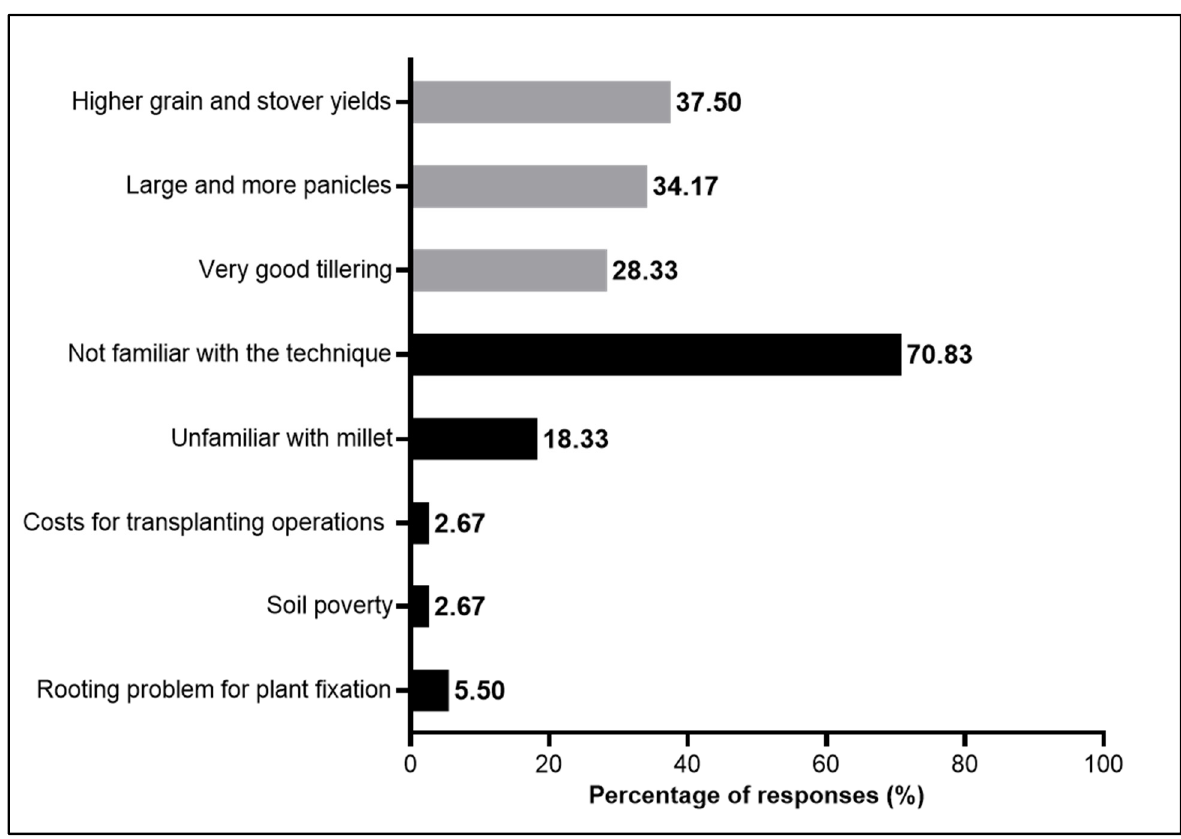
Figure 7. Major benefits (in gray) and constraints (in black) of transplanting as listed by farmers. All surveyed millet producers who practice or intend to use transplanting noted three major benefits of transplanting viz. high productivity (37.50% of responses), large